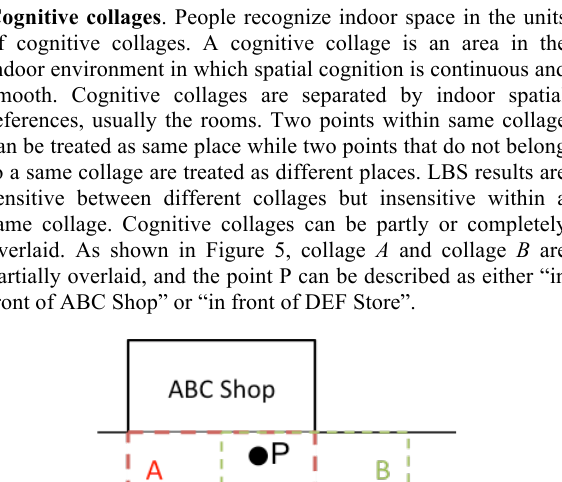
Figure 3. Topology relations on outdoor maps